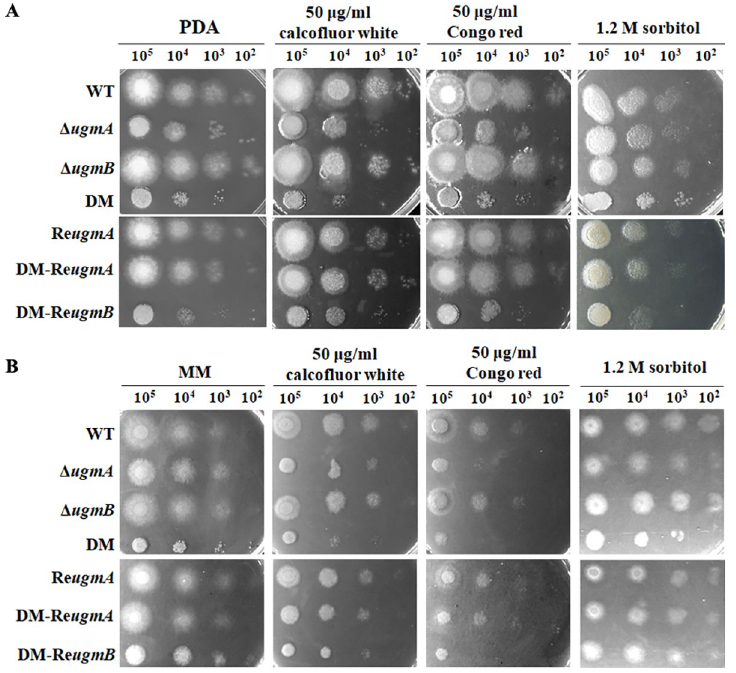
Fig 4. Sensitivities of the mutants to cell wall stressors. A serial dilution of conidia of 1 × 10 5 − 1 × 10 2 of the WT, the mutants and complemented strains were inoculated on PDA (A) or MM (B) agar plates supplemented with 50 μ g/ml Congo red or 50 μ g/ml calcofluor white. Strains were cultured at 28˚C. DM, double mutant; DM-Re ugmB , double mutant with a copy of re-introduced ugmB ; DM-Re ugmA , double mutant with a copy of re-introduced ugmA .